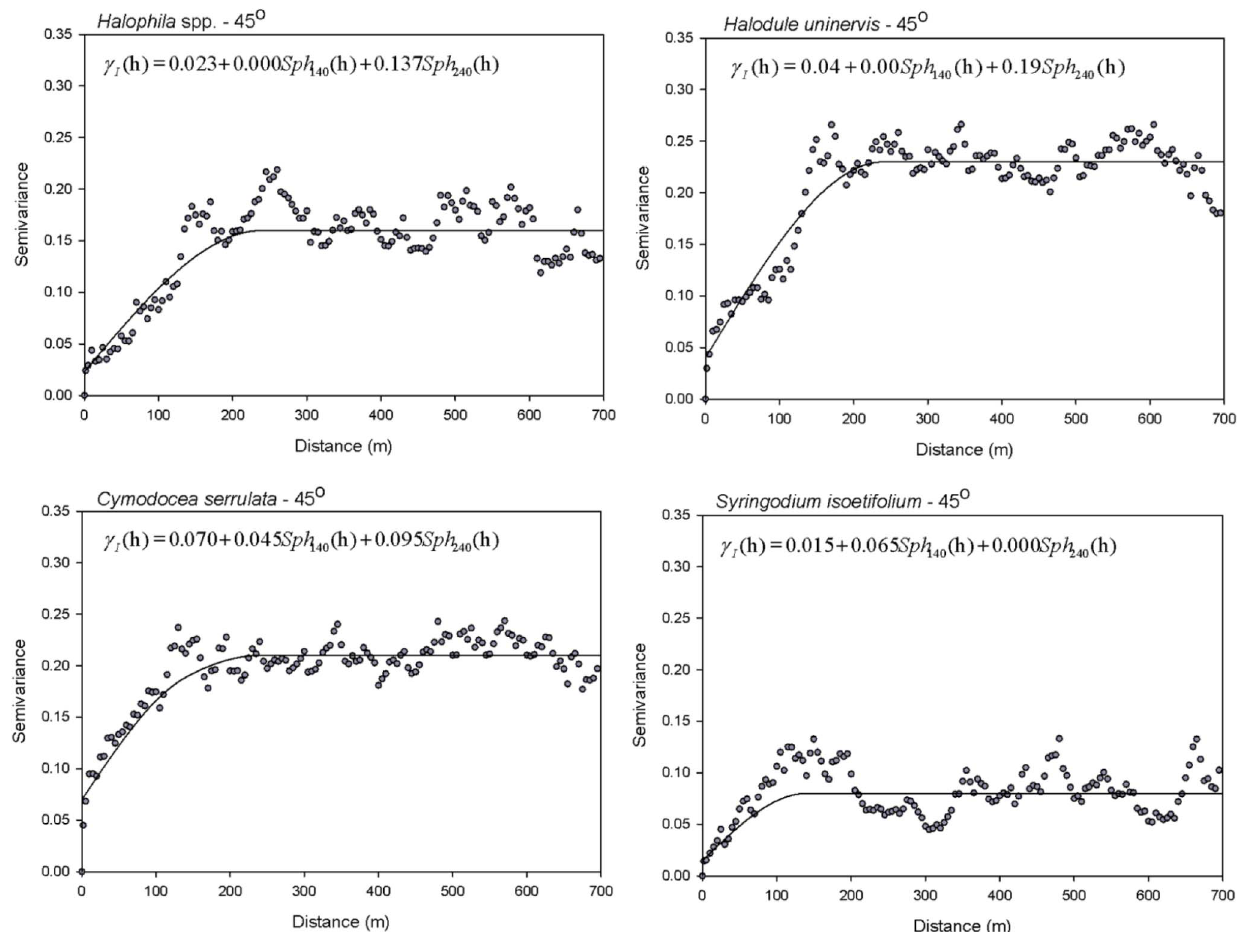
Figure 5. Sample variograms (dots) and the fitted Linear Model of Coregionalization (solid lines) of seagrass species presence/ absence in the across-shore direction (45 u ) in Pulau Tinggi, Malaysia. Sample variograms are displayed with a lag of 5 m and a tolerance of 2.5 m.